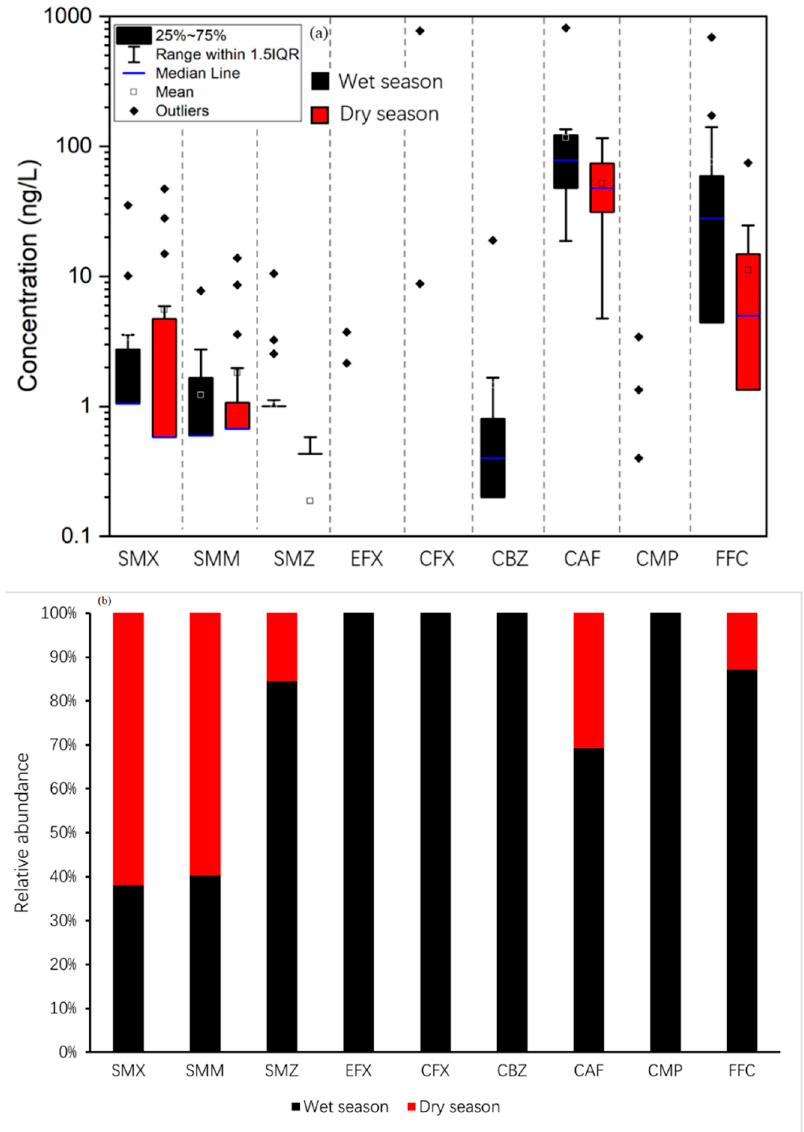
Figure 4. The concentrations ( a ) and relative abundances ( b ) of different PPCPs among the wet and dry seasons in the Lianjiang River. The IQR represents the interquartile range (25% to 75%). In this study, out of all sulfonamides (SMX, SMM, and SMZ), the total concentration of SMX was relatively higher with 64.80 and 105.19 ng L − 1 in the wet and dry seasons, respectively. The concentration was detected at most sampling points below 5 ng L − 1 , except three sampling points (R15 = 14.9 ng L − 1 , R17 = 47.15 ng L − 1 , and R19 = 28 ng L − 1